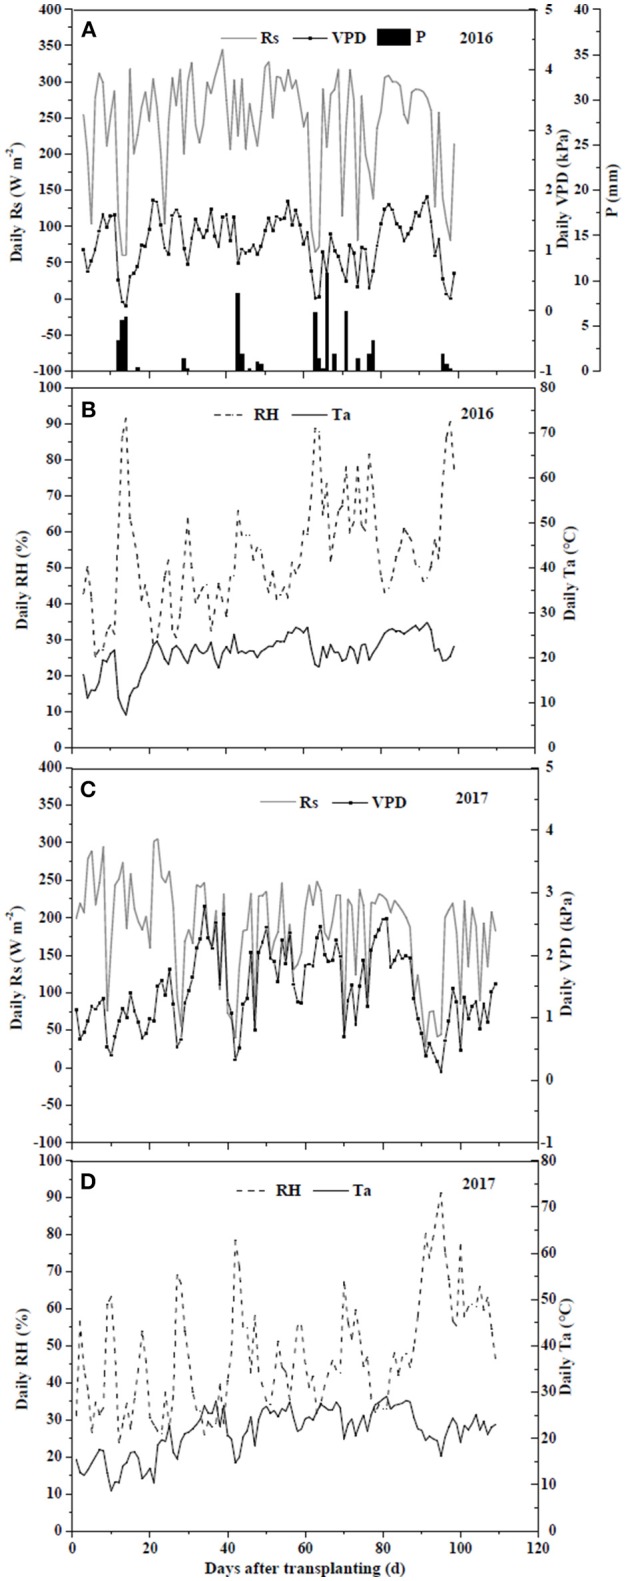
Climate variances including daily solar radiation (Rs) (A,C), relative humidity (RH) (B,D), temperature (Ta) (B,D), and vapor pressure deficit (VPD) (A,C) of field experiment in 2016 and greenhouse experiment in 2017.